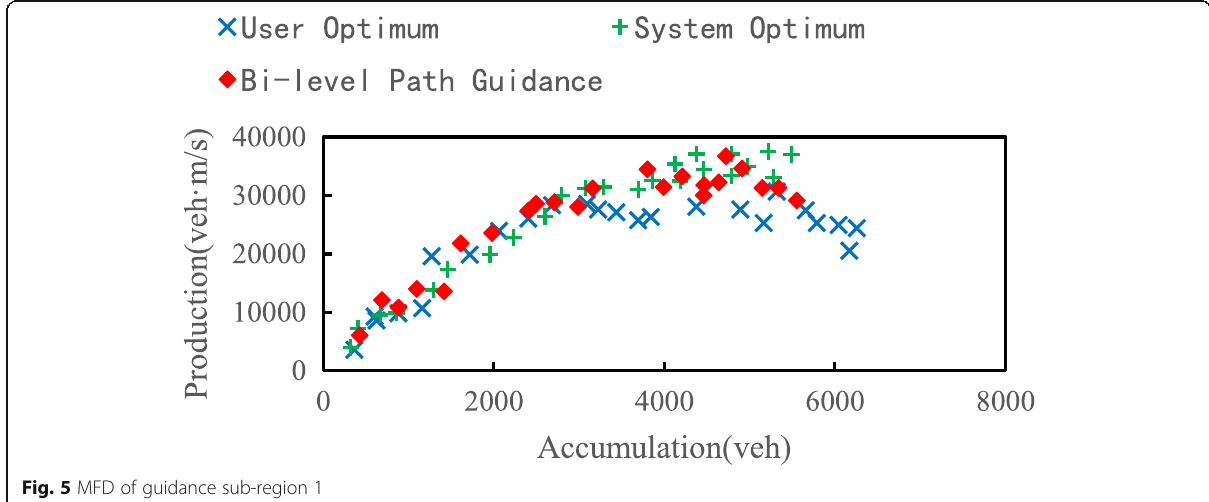
Fig. 5 MFD of guidance sub-region 1